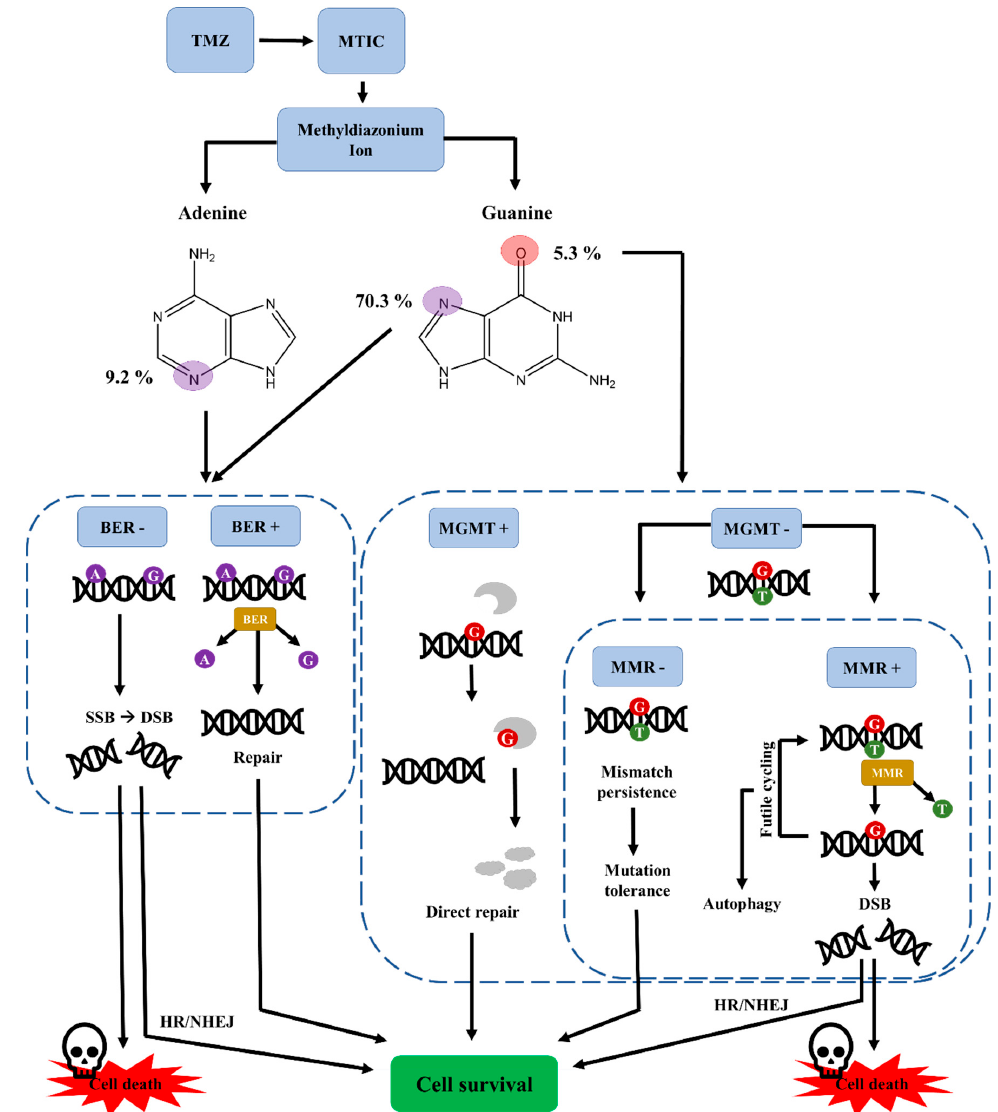
Figure 2. TMZ-induced alterations and DNA repair mechanisms involved in cellular response. The methyldiazonium ion, a highly electrophilic ion, methylates nucleophilic sites in the DNA. Lack of BER or low MGMT levels in combination with functional MMR are required for cell